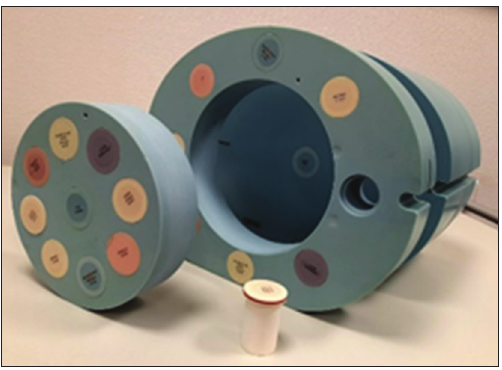
FIGURE 1. Computerized imaging reference systems 062M phantom.